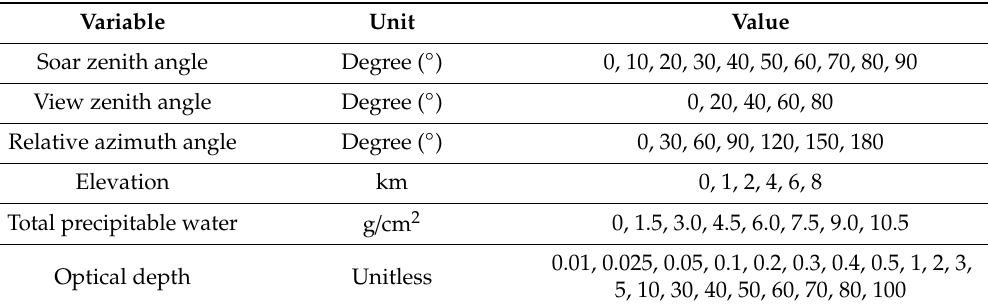
Table 2. Details of each dimension of the reflectance and radiative flux look-up tables (LUTs). Variable